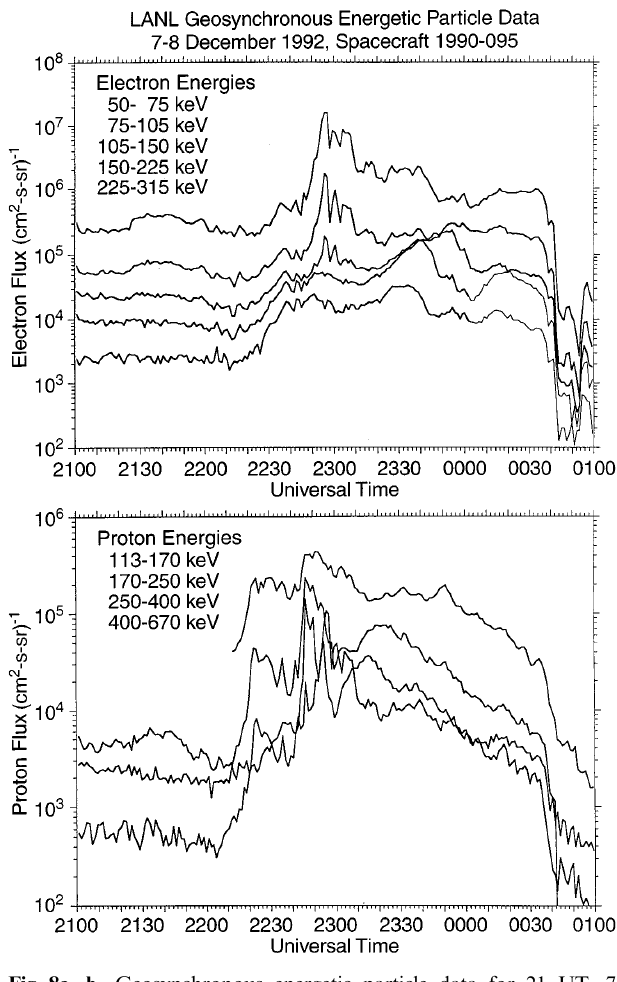
Fig. 8a, b. Geosynchronous energetic particle data for 21 UT, 7 December, 1992–01 UT, 8 December, 1992, from spacecraft 1990-095 (local time = UT + 0031). a Is energetic electron data and b is energetic proton data. The flux ranges are indicated to the left of the two panels